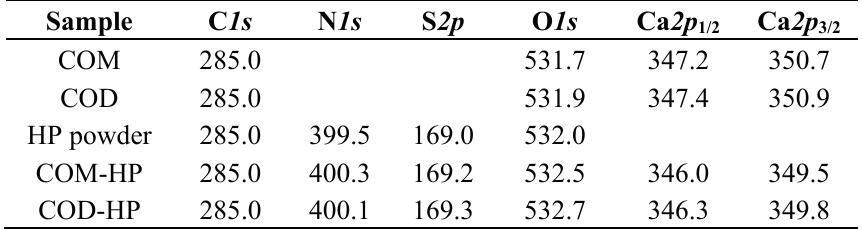
Figure 6. XPS survey scan for ( a ) COM-HP; and the narrow scans of ( b ) C 1s ; ( c ) N 1s ; ( d ) S 2p ; ( e ) O 1s ; and ( f ) Ca 2p . Table 1. Binding energy (eV) of HP, COM, COD and their